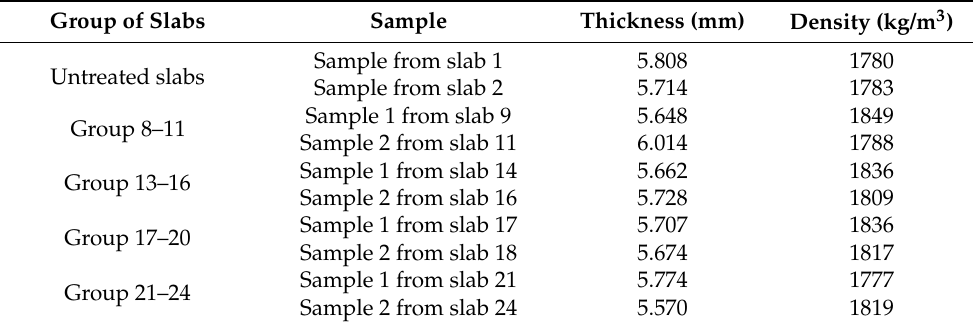
Figure 6. Characterization of solar aged prototype material: ( a ) optical image (in solar furnace) after 10,000 cycles; ( b ) XCT images (cropped) at the same midsection plane before and after solar ageing, with cross-section of the developed crack; ( c ) visualization of the crack, using the nominal strain in the x-direction, due to the relative displacements measured by digital volume correlation between tomographs. Table 4. Physical characteristics of the samples (all diameter 12.7